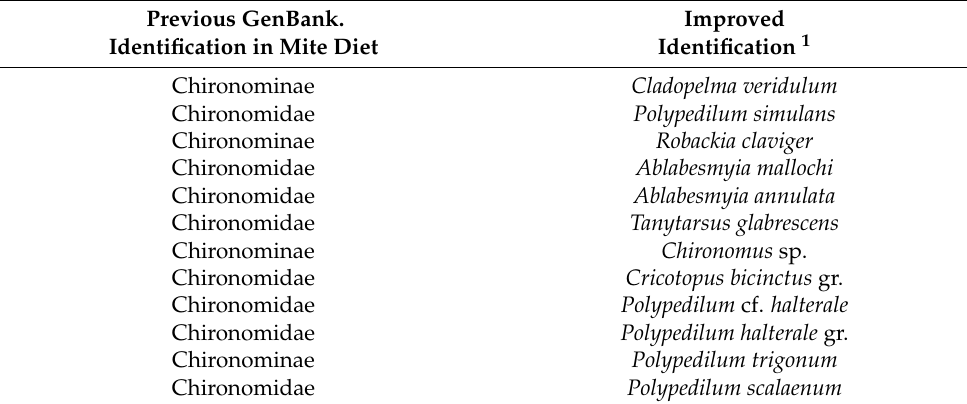
Table 3. Summary of family to genus improvements.